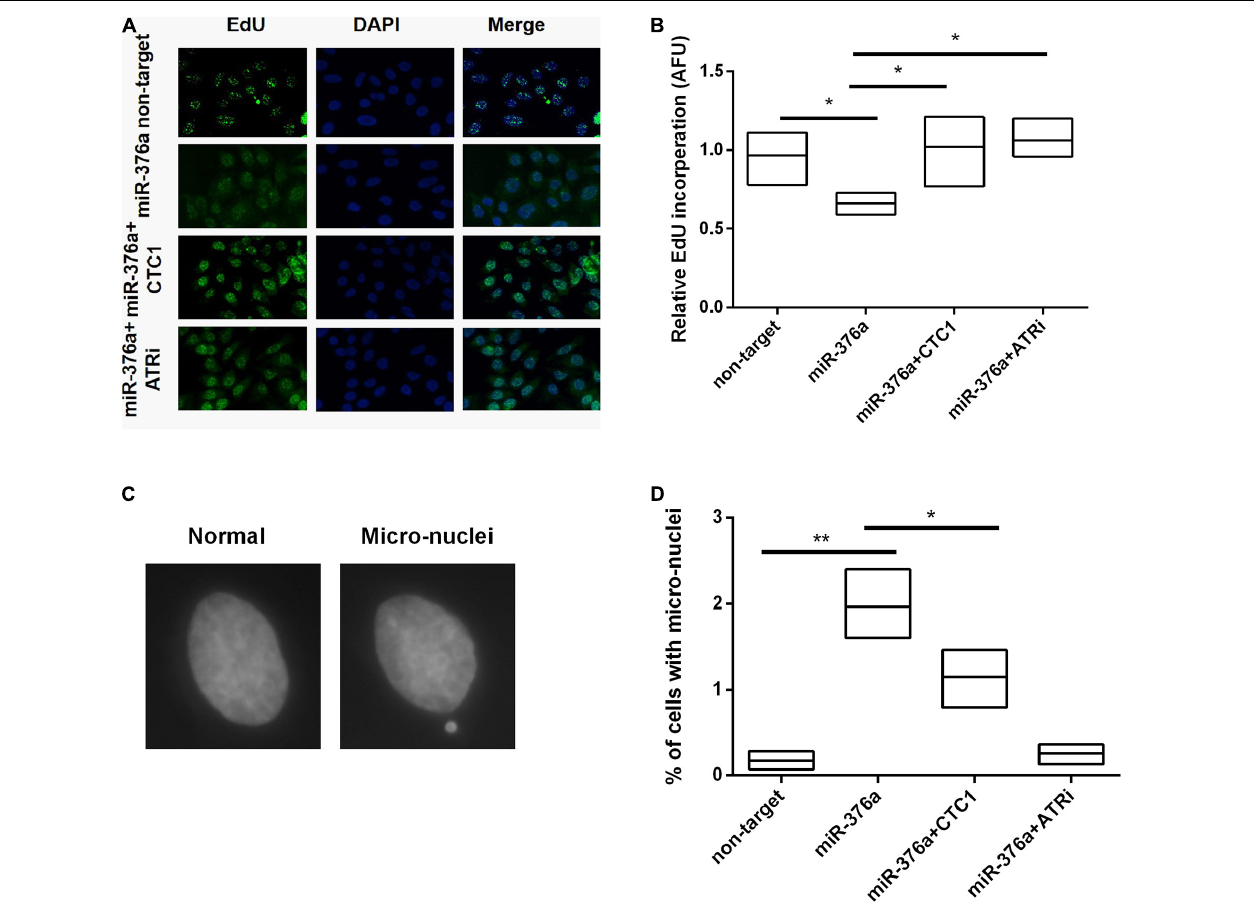
FIGURE 5 | miR-376a induces genomic DNA replication deficiency. (A) Genomic DNA replication efficiency determined by 5-ethynyl-2 (cid:48) -deoxyuridine (EdU) incorporation. Incorporated EdU ( green ) and nuclei stained with DAPI ( blue ). (B) The relative EdU incorporation in the different treatment groups was calculated and statistically analyzed. (C) Representative images of normal nuclei and micronuclei. (D) The number of cells with micronuclei in each treatment group was calculated and the statistics of percent of cells with micronuclei was determined by one-way ANOVA. * P < 0.05 and ** P <